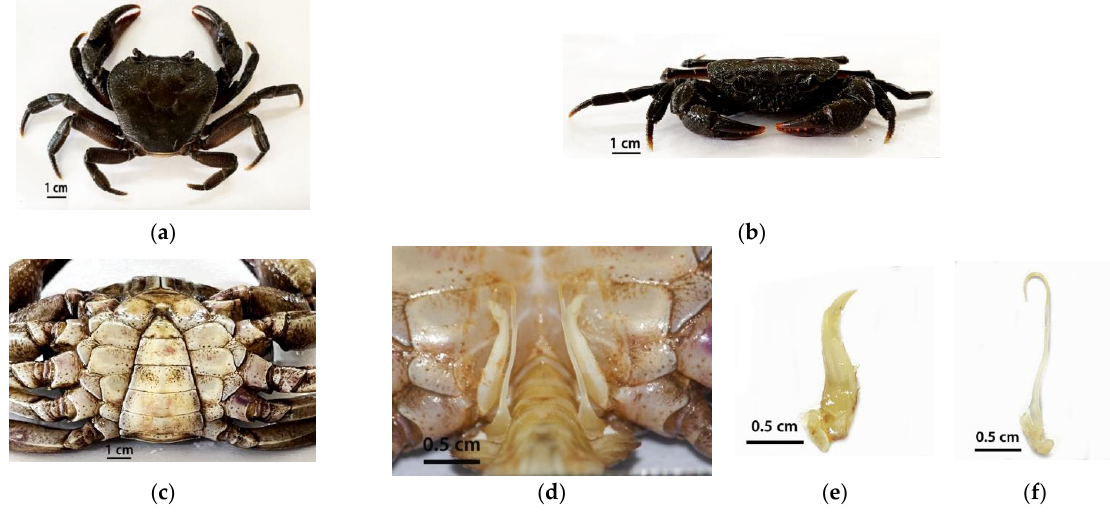
Figure 2. External morphology of I. bhumibol : ( a ) carapace; ( b ) anterior view; ( c ) male abdomen; ( d ) male’s gonopod; ( e ) first gonopod; ( f ) second gonopod.